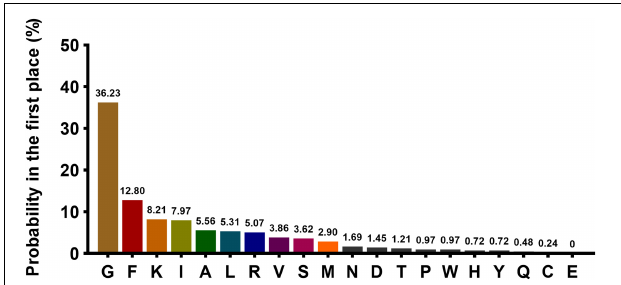
FIGURE 2 | The probability of the 20 amino acids present at the N terminal. The X -axis represents 20 amino acids, and Y -axis represents the probability of each amino acid occurring in the first place at the N